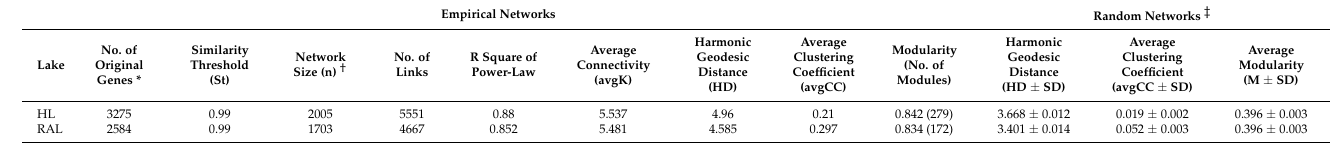
Table 2. Major topological properties of the empirical fMENs of core genes in the HL and the RAL and their associated random networks. * The number of genes used in the network construction. † The number of nodes in the fMEN. ‡ The parameters were generated from 100 randomly rewired